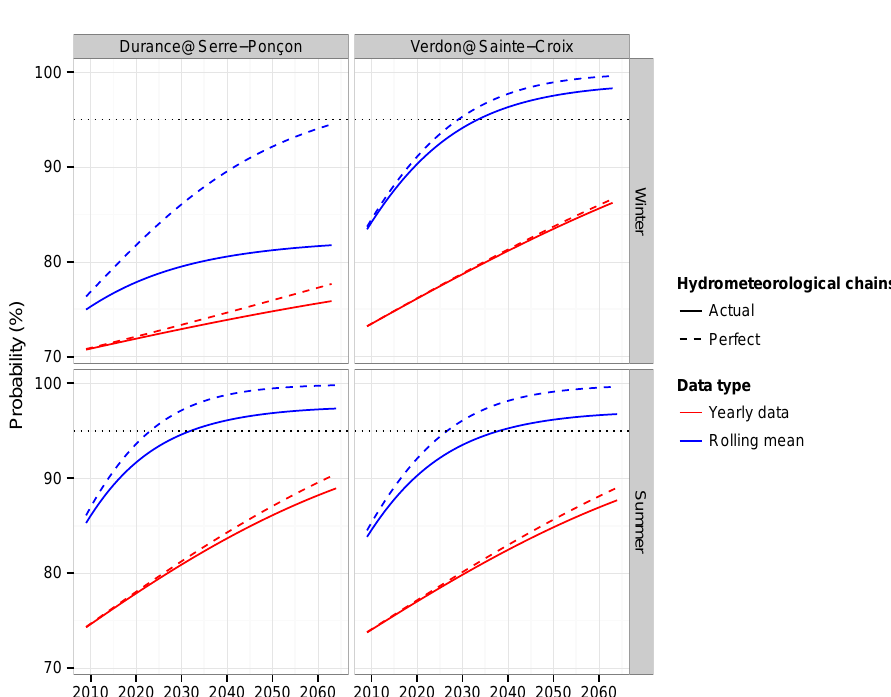
Figure 10. As for Fig. 9, but for yearly anomalies.